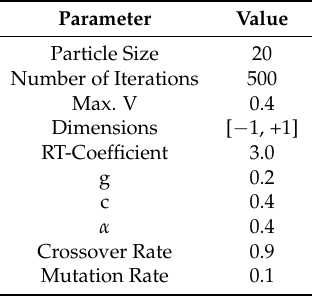
Table 14. GWD parameters and values.